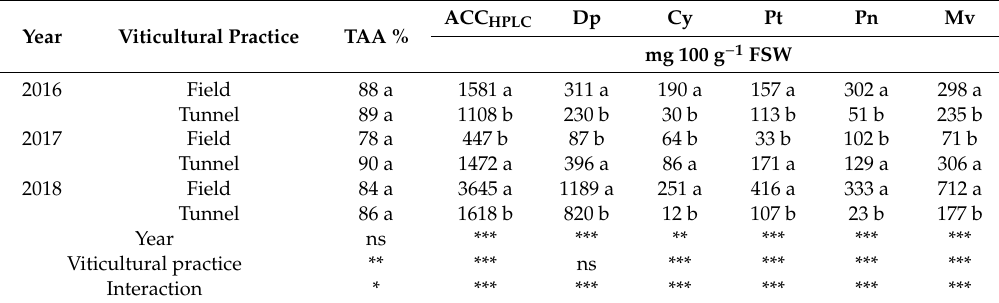
Table 6. The e ff ect of viticultural practice on the total antioxidant activity, total anthocyanins, and individual anthocyanins of ‘Rondo’ grapes (2016 −